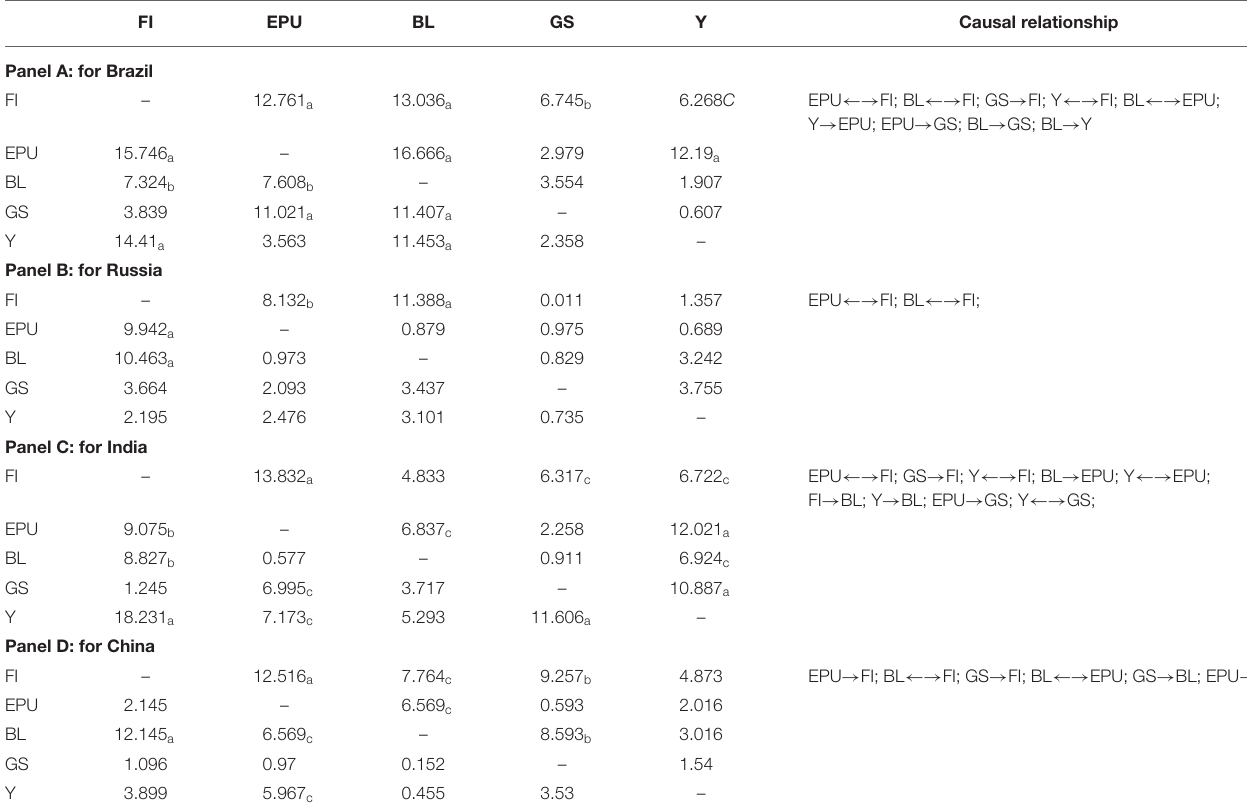
TABLE 6 | Results of causality test: financial innovation measured by M 2 /M 1 . FI EPU BL GS Y Causal relationship Panel A: for Brazil